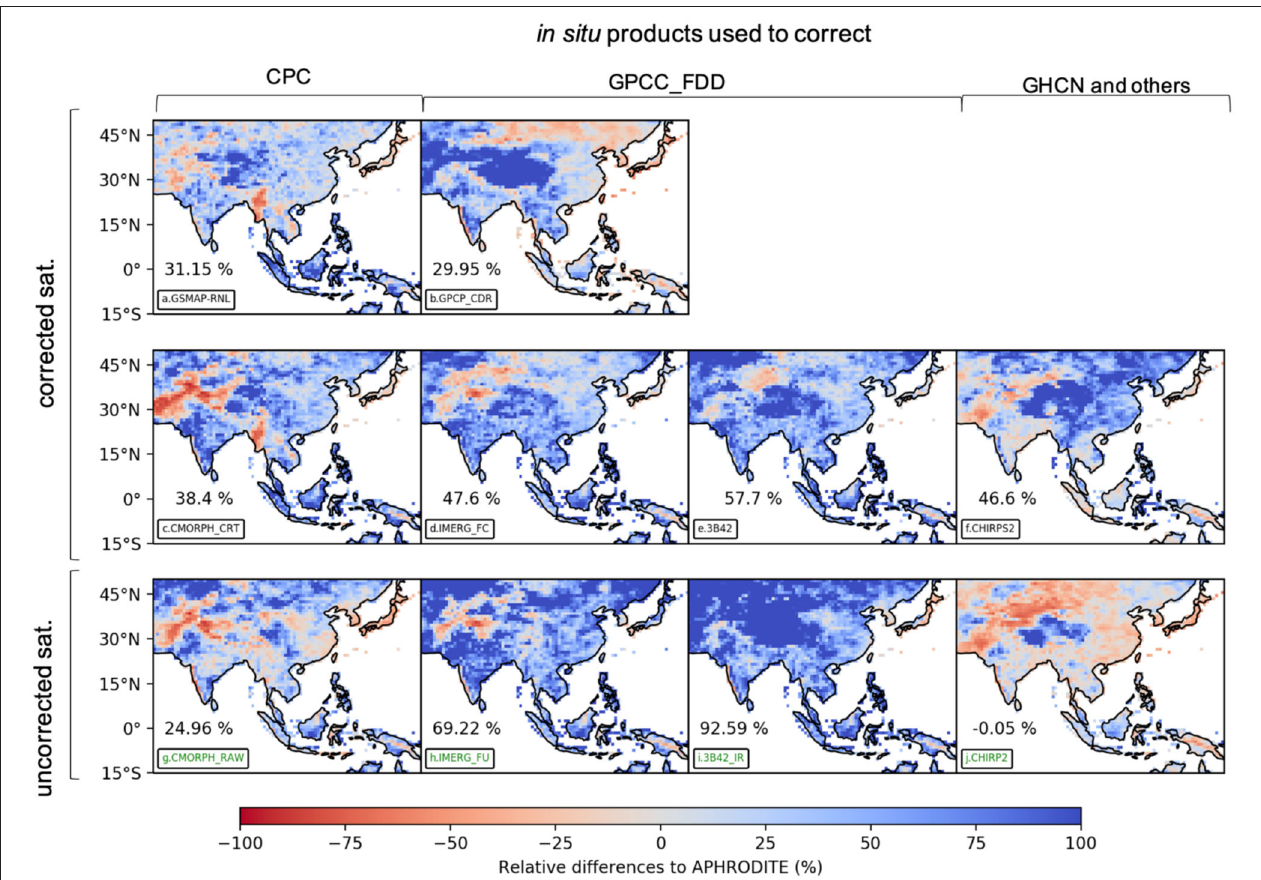
FIGURE 3 | The relative difference to APHRODITE (in %) of the climatological (over the period of 2001–2013) annual wettest day (Rx1day) for corrected satellite products (black labels, two upper panels) (a) GSMAP_RNL, (b) GPCP_CDR, (c) CMORPH_CRT, (d) IMERG_FC, (e) 3B42, (f) CHIRPS2, and uncorrected satellite products (green label, lower panel) (g) CMORPH_RAW, (h) IMERG_FU, (i) 3B42_IR, (j) CHIRP2. The number inserted on each panel indicates the regional average of these relative differences. The in situ products that satellite products used for their correction to rain gauges are also mentioned at the top of the figure.